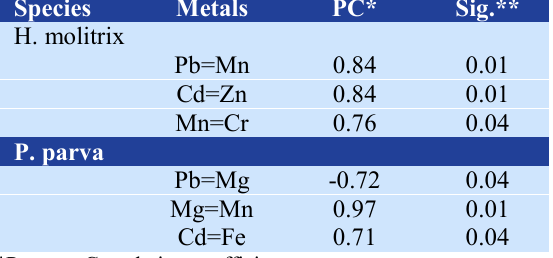
Table 3. Correlation coefficients of trace elements contents in the muscle tissue of two fish species caught in Zarivar Wetland Species Metals PC*